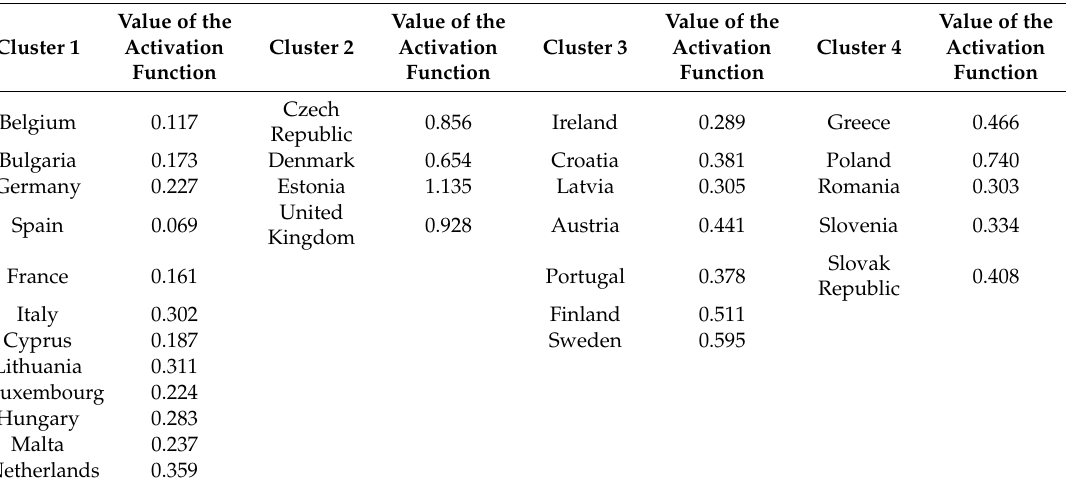
Table 11. Division of the EU countries into similar groups in terms of the emission of harmful substances compared to the number of inhabitants along with the values of the activation function (own